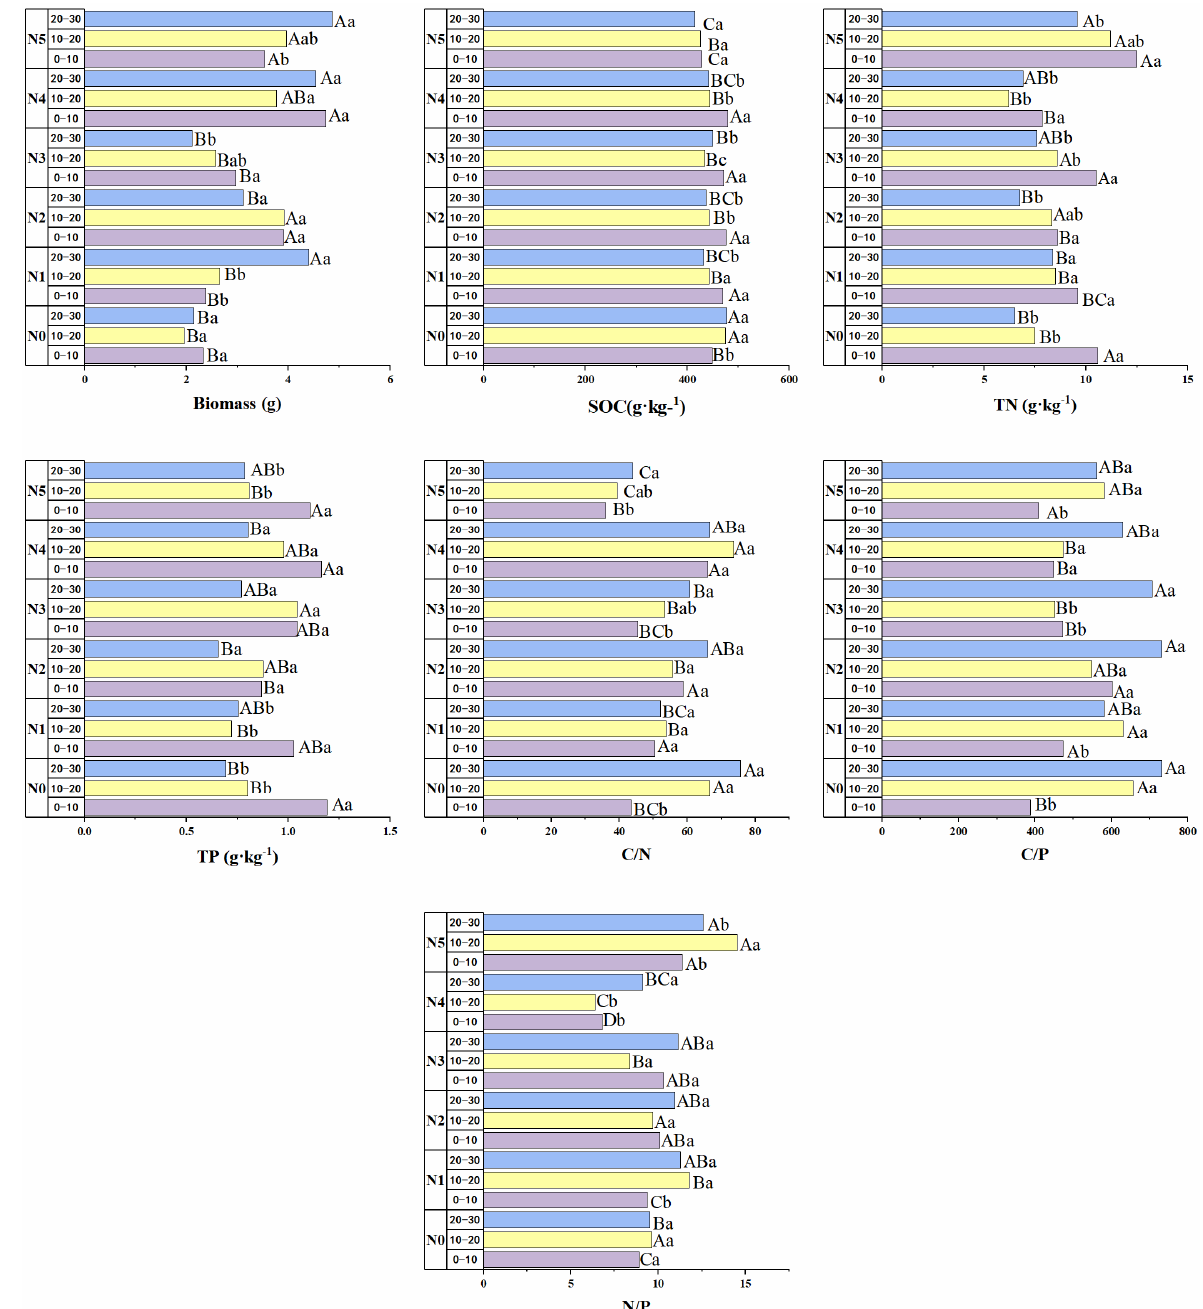
Figure 2. One-way ANOVA of soil ecological stoichiometry and biomass characteristics of Picea schrenkiana in different soil layers under different nitrogen source input levels in the Tianshan Mountains, Xinjiang. Different capital letters indicate significant differences in the ecological stoichiometry of elements in the same soil layer under different nitrogen sources ( p < 0.05); different lowercase letters indicate significant differences in the ecological stoichiometry of different soil layer elements under the same nitrogen source addition ( p < 0.05).